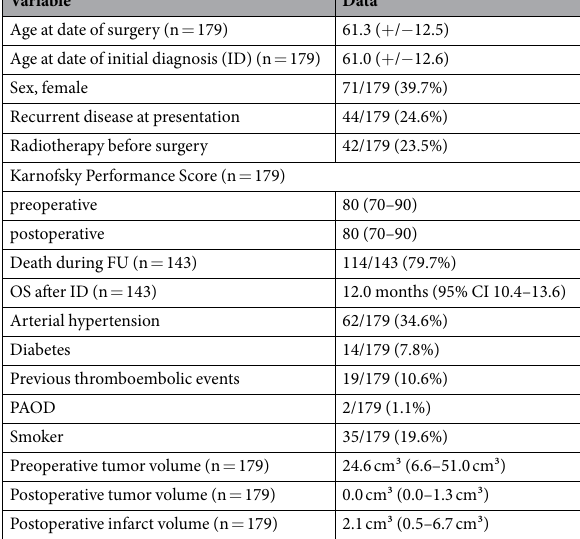
Table 1. In total, 159/179 patients showed ischemic changes on the postoperative MRI. Median infarct volume in all patients (n = 179) was 2.1 cm³ (0.5–6.7 cm³). Figure 1 shows an example of a volumetric measurement of